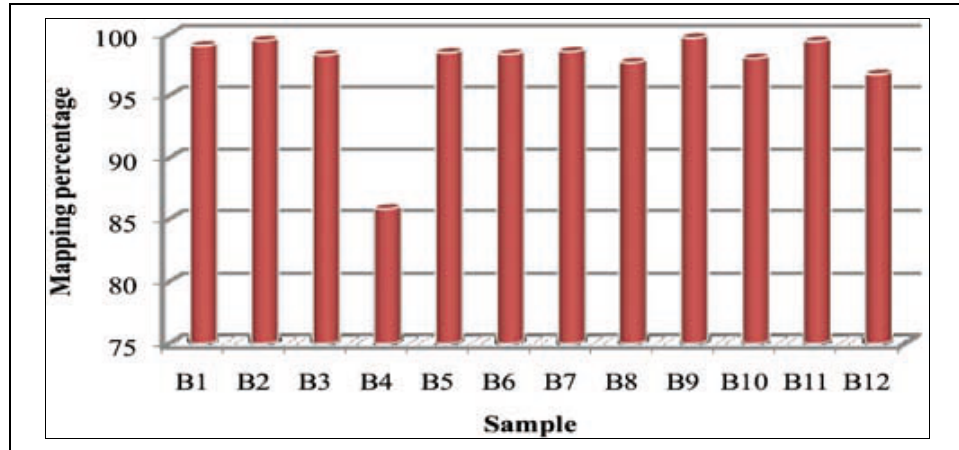
Fig. 1. Alignment of processed reads of buffalo milk somatic cells with human reference genome.